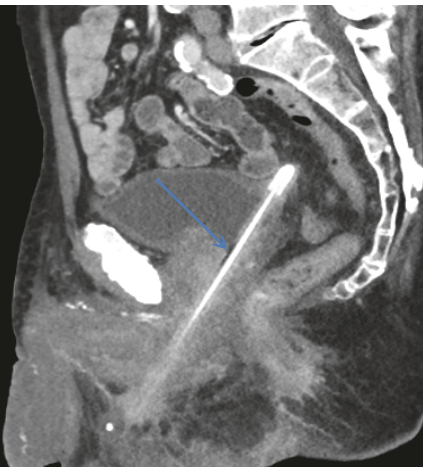
Figure 1: Sagittal images from CT pelvis showing pencil extending from the bladder dome (which is tented superiorly) through the prostatic urethra then through a perforation in the bulbar urethra.